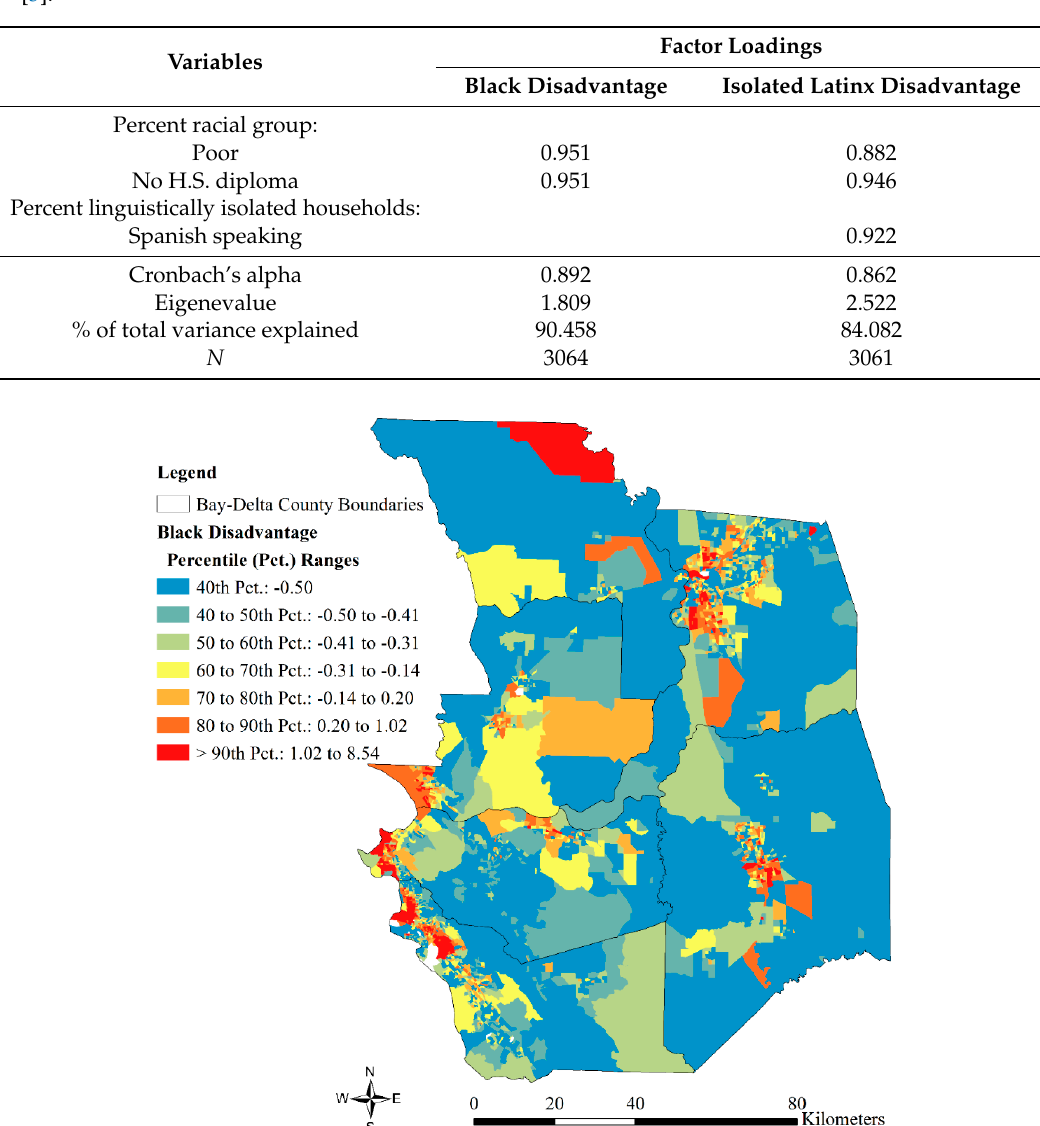
Figure 4. The spatial distribution of Black disadvantage in the Bay-Delta, 2000 (N = 3064).